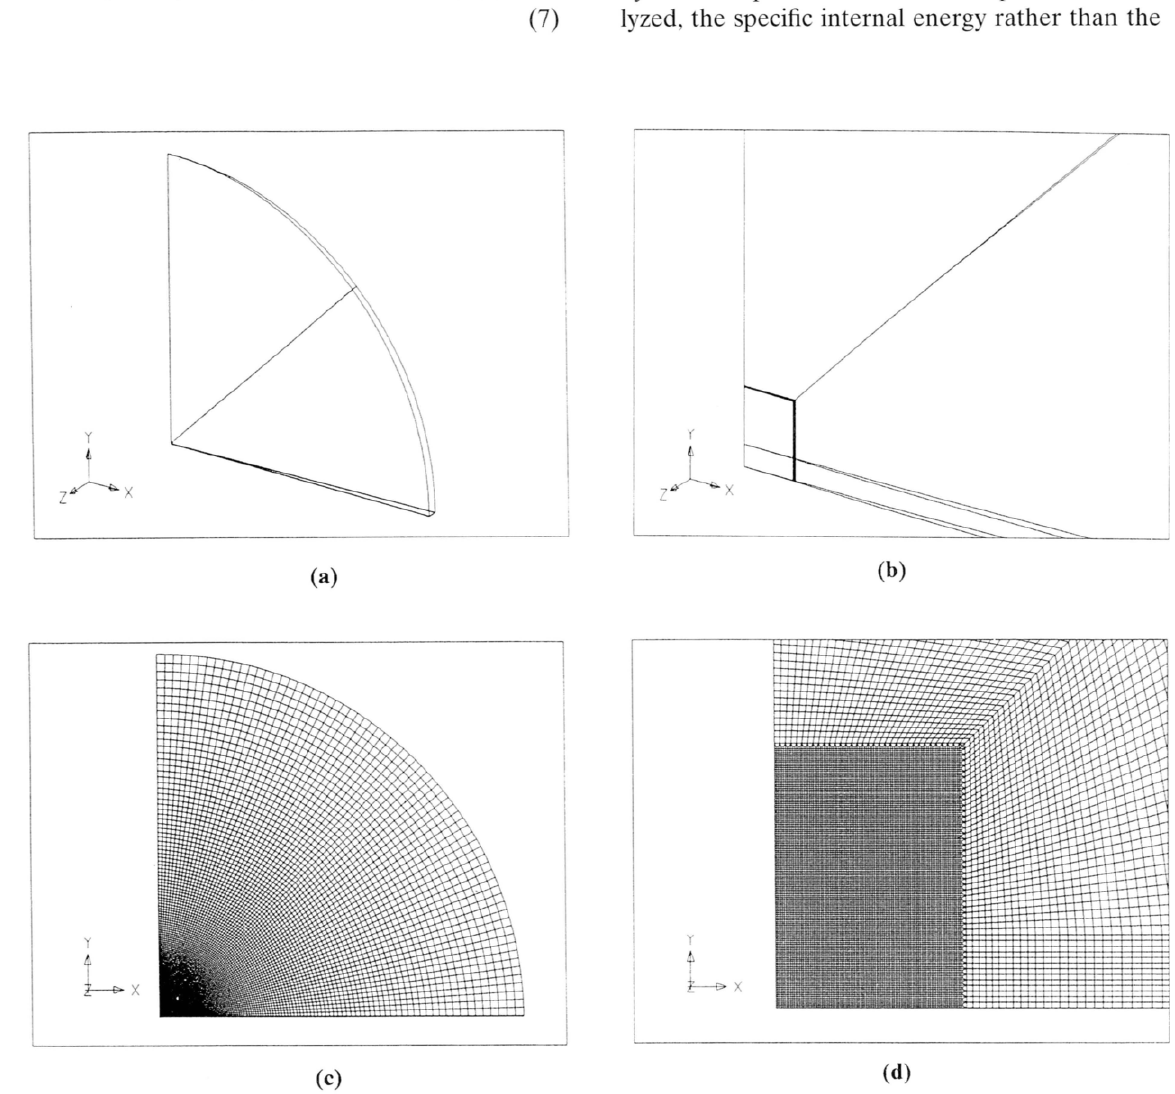
FIGURE 4 Finite element model for the bubble near the boundary problem